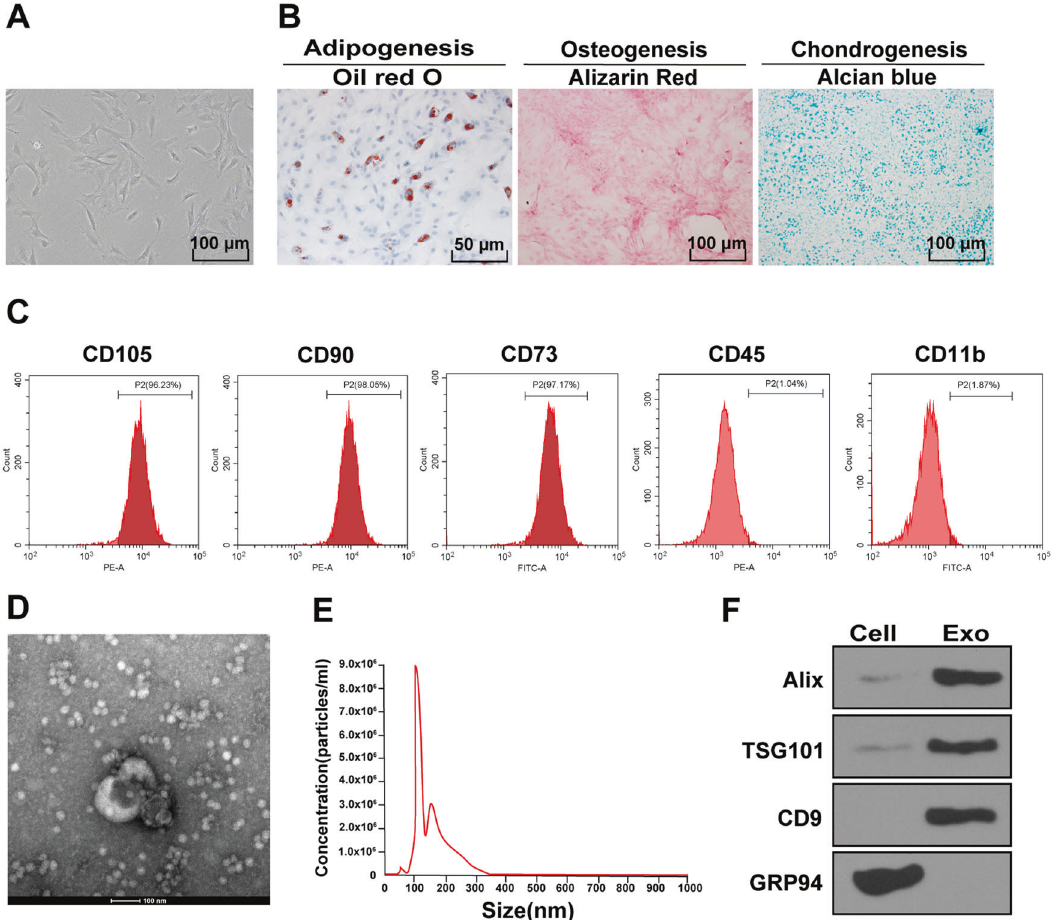
Fig. 2 Isolation and identi fi cation of ADMSCs and ADMSC-exosomes. A The morphological characteristics of primary ADMSCs were observed under the inverted microscope. B Adipogenic (left), osteogenic (middle), and chondrogenic (right) differentiation experiments of ADMSCs. C The surface markers of ADMSCs were detected using fl ow cytometry. D The diameter of ADMSC-exosomes was observed under the TEM. E The diameter distribution and concentration of exosomes were detected using NTA. F The exosome marker proteins (Alix, CD9, and TSG101) and endoplasmic reticulum protein (GRP94) were detected using Western blot. The cell experiment was repeated three times